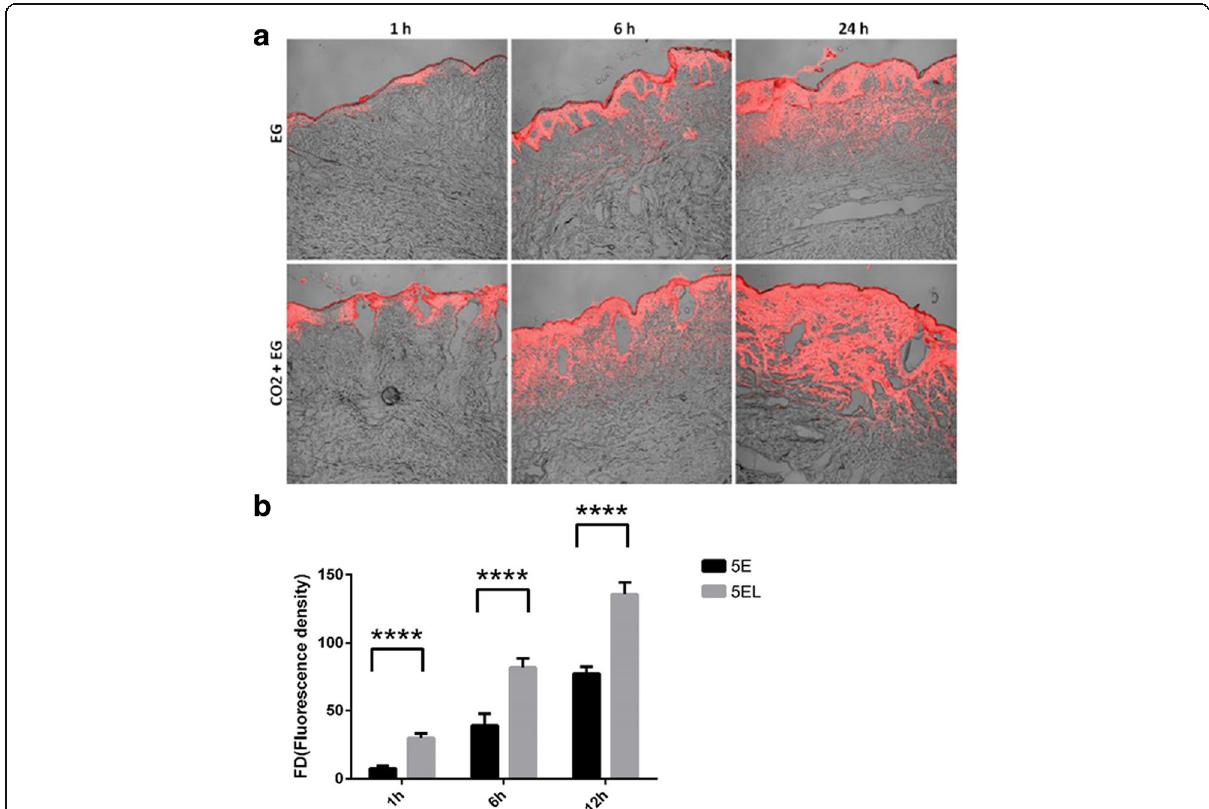
Fig. 3 CO 2 fractional laser promotes permeability through hypertrophic scars in vitro . a The red fluorescence is labeled ethosomes permeated hypertrophic scar tissues after 1, 6, and 24 h in vitro. b The fluorescence intensity of Rhodamine 6GO labeled ethosomes on hypertrophic scar